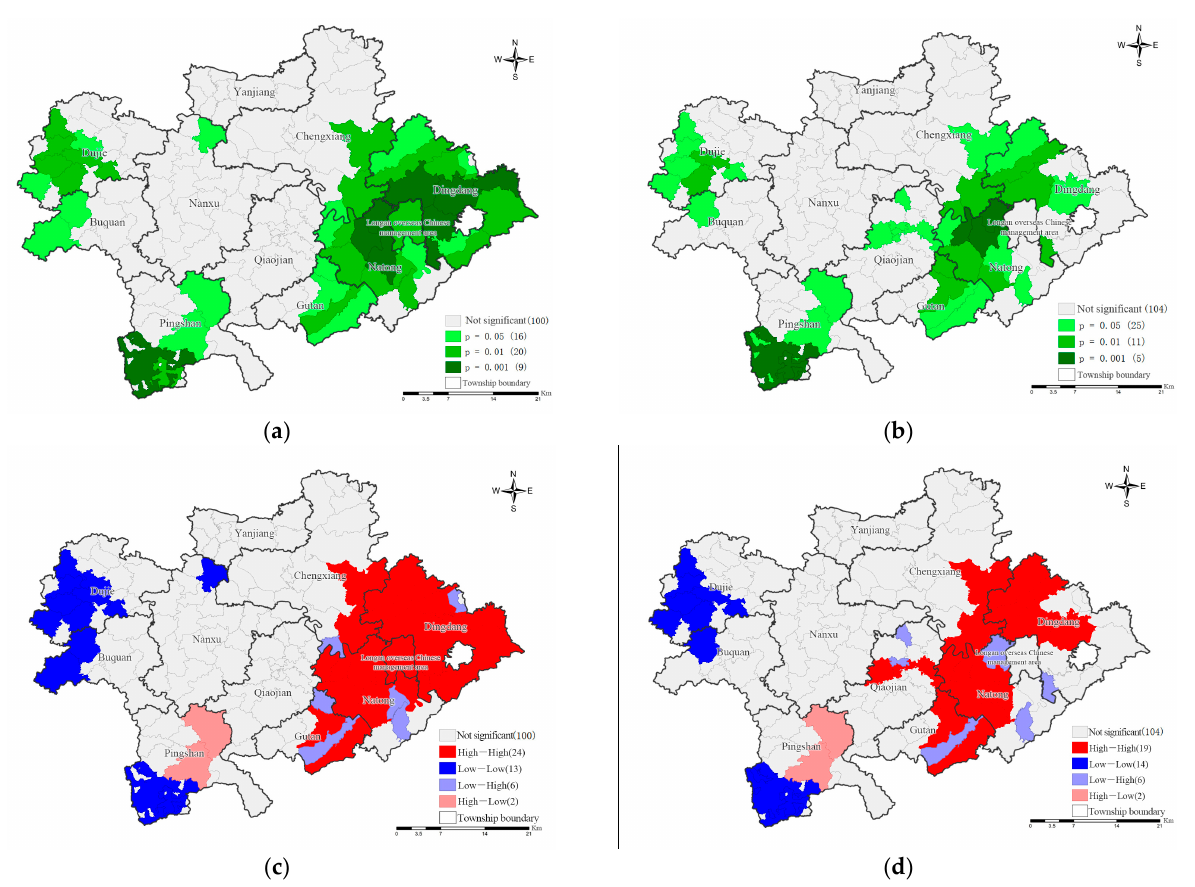
Figure 9. ( a ). Significance grading chart for 2010; ( b ). Significance grading chart for 2020; ( c ). Aggregation based on locally spatial correlation for 2010; ( d ). Aggregation based on locally spatial correlation for 2020.